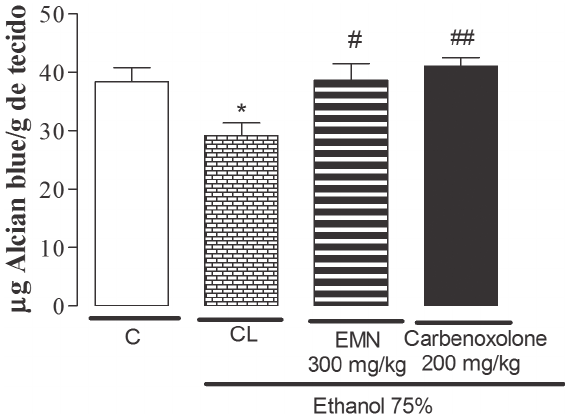
Figure 3 - Effect of ethanolic root extract of Memora nodosa (EMN) on gastric mucus content. Results were expressed as Mean ± SEM. n = 9. Data were analyzed by ANOVA followed by Newman-Keuls test. *p < 0.05 compared with control group (C). # p < 0.05; ## p < 0.01 compared with control group with lesion (CL).